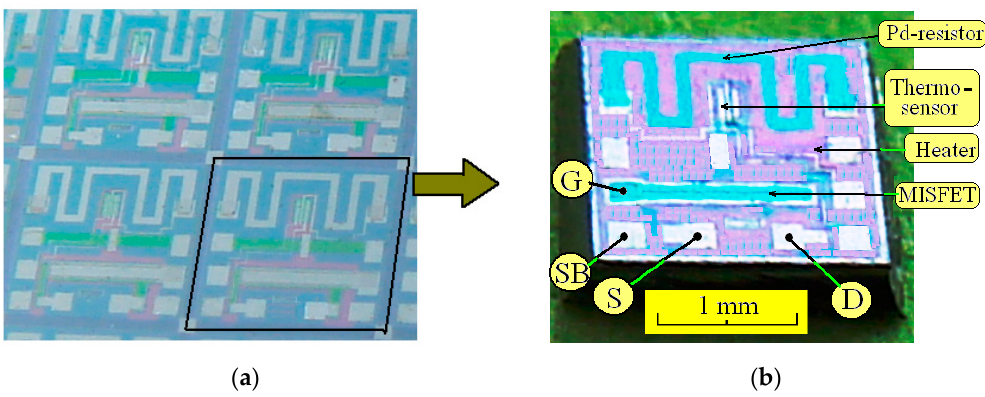
Figure 1. Photos of the sensor chips. ( a ) The fragment of the silicon wafer, undivided into chips; ( b ) The separate chip and designations of the contact pads of the MISFET element: gate (G), source (S), drain (D) and substrate (SB).